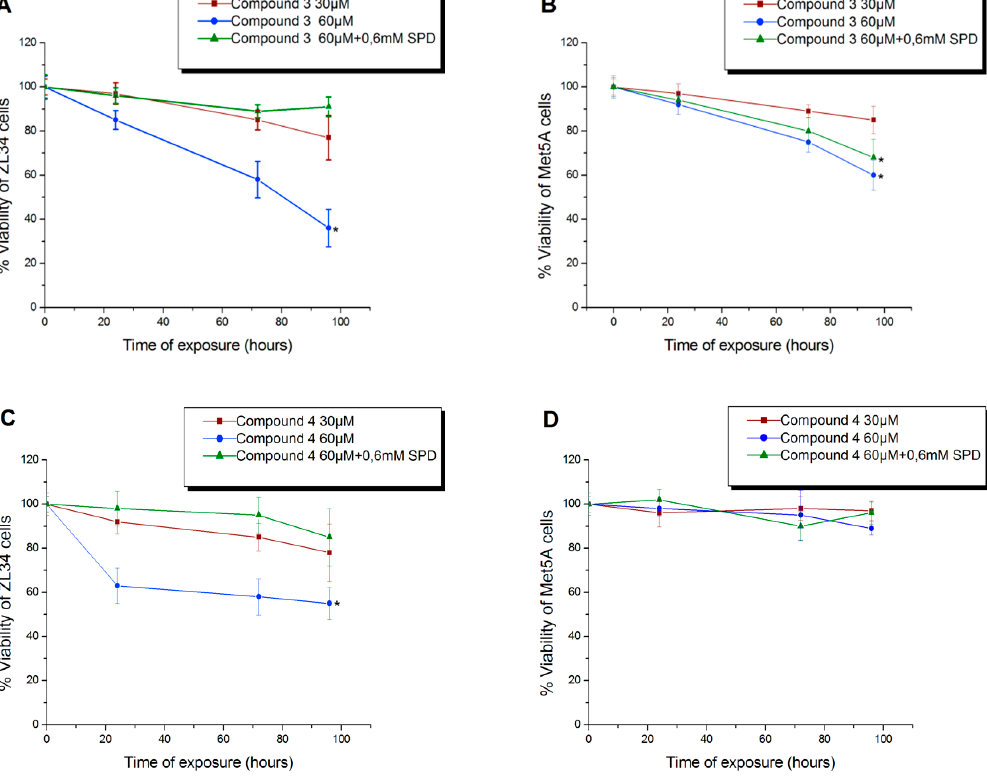
Figure 2. Cytotoxicity of compounds 3 ( A , B ) and 4 ( C , D ) on ZL34 mesothelioma cells and Met5A mesothelial immortalized cells. * Significantly different values from those measured in control samples ( p <0.05).